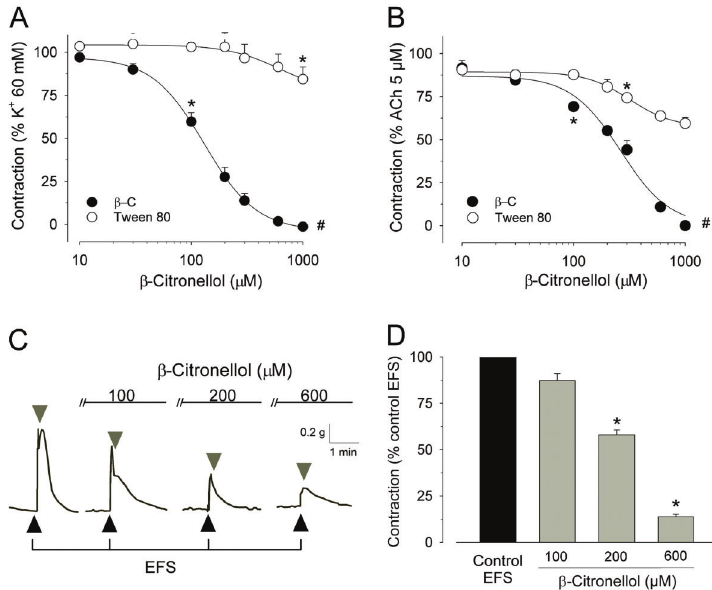
Figure 1. Myorelaxant and antispasmodic effects of b -citronellol on isolated rat trachea. Panels A and B show the inhibitory effects of b -citronellol (10 – 1000 m M b -C) added to the steady state of